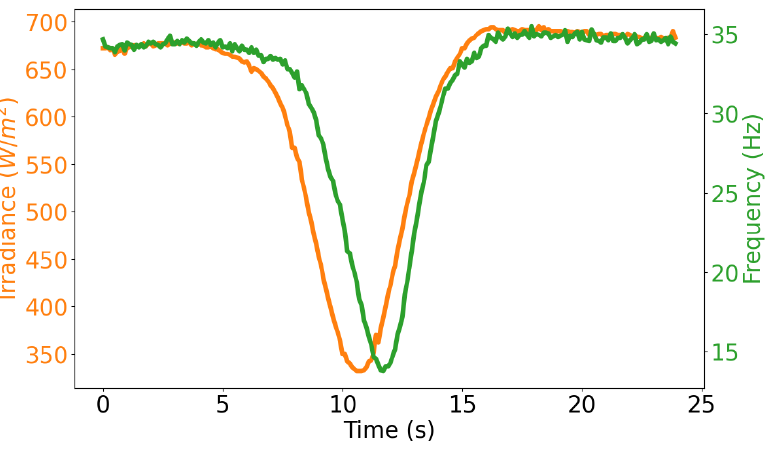
Figure 5. Cloud 1: Similarity of irradiance and frequency response shapes.